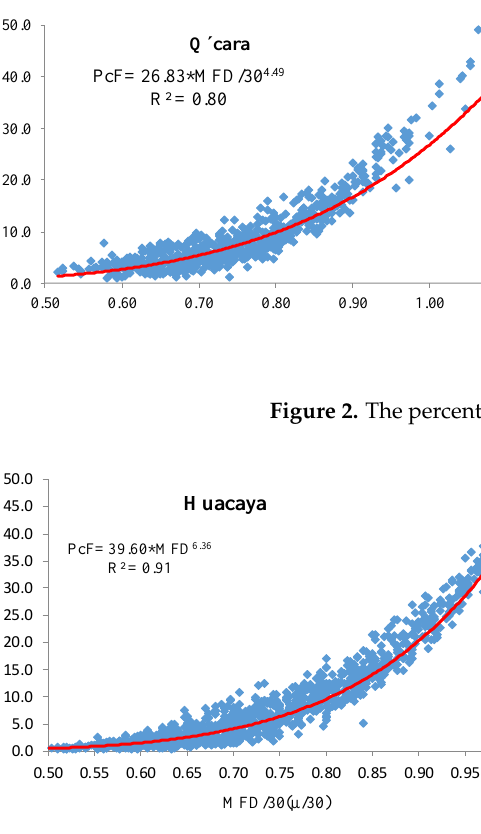
Figure 3. The percentage of fibres >30 µm on MFD/30 µm in two alpaca biotypes.